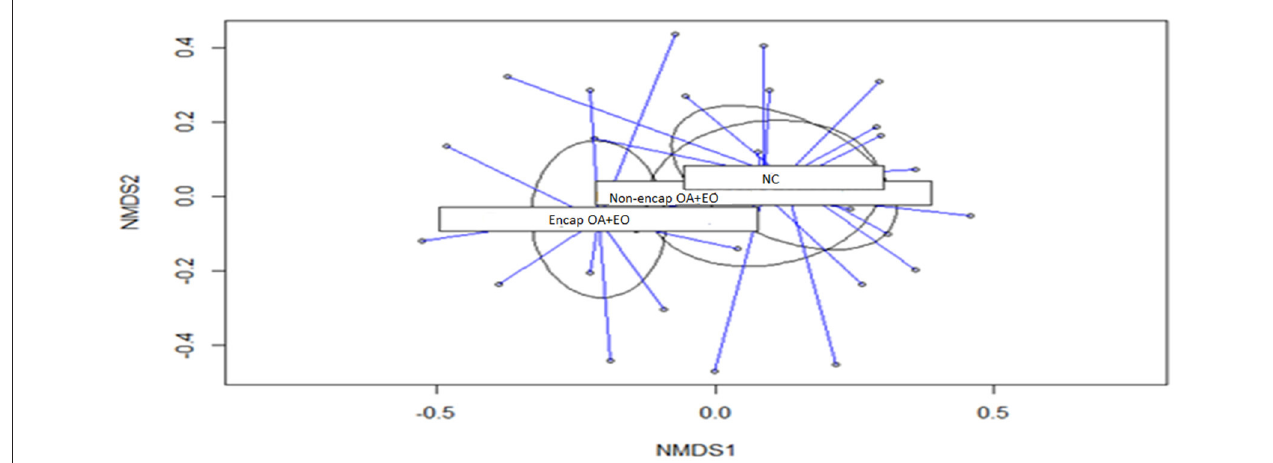
FIGURE 3 | Non-metric multidimensional scaling (NMDS) ordination plot of bacterial communities of the different treatment groups ( p = 0.430). NC, negative control; OA, organic acid: fumaric; EO, essential oil: thymol. Encap, microencapsulated; Non-encap, non-microencapsulated. Inclusion levels: microencapsulated fumaric acid: 1.5 g/kg; microencapsulated thymol: 3 g/kg; non-microencapsulated fumaric acid: 0.9 g/kg; non-microencapsulated thymol: 0.6